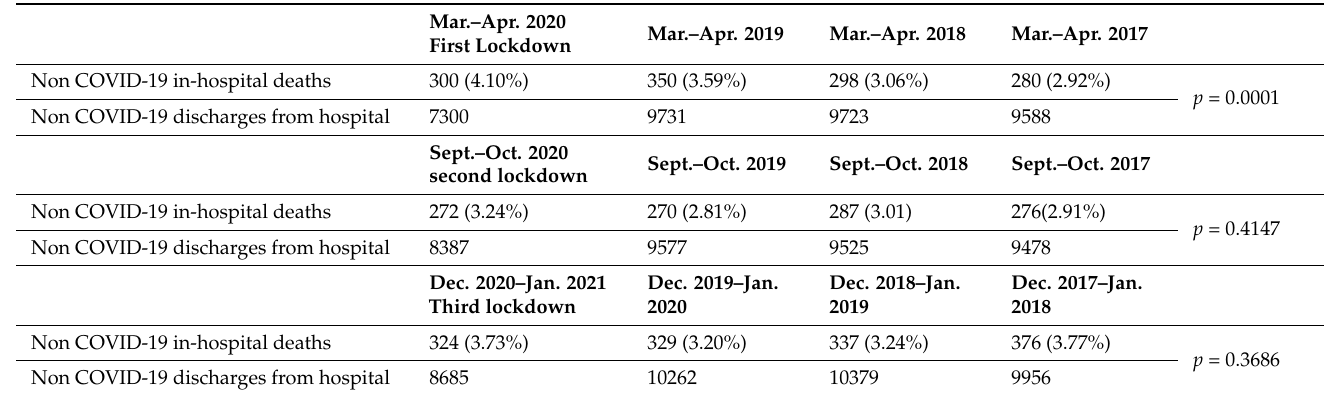
Table 2. In-hospital non-COVID-19 deaths vs. non-COVID-19 discharges from hospital